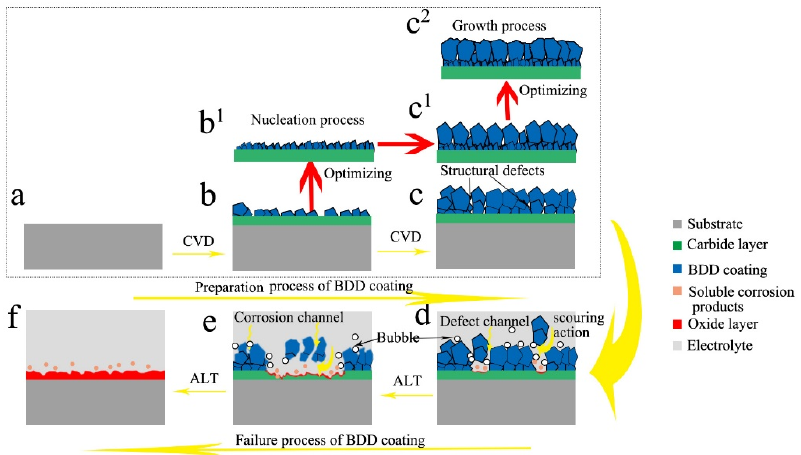
Figure 11. The preparation and failure process of the Ti / BDD coated electrode. The sample: ( a ) before deposition; ( b ) after the nucleation process; ( b 1 ) after optimizing the nucleation process; ( c )as-depostied without any optimizing processes; ( c 1 ) as-depostied with optimizing the nucleation process; ( c 2 ) as-depostied with optimizing the nucleation process and adoting the gradient boron doping method; ( d ) in the first stage of the failure process; ( e ) in the second stage of the failure process; ( f ) completely